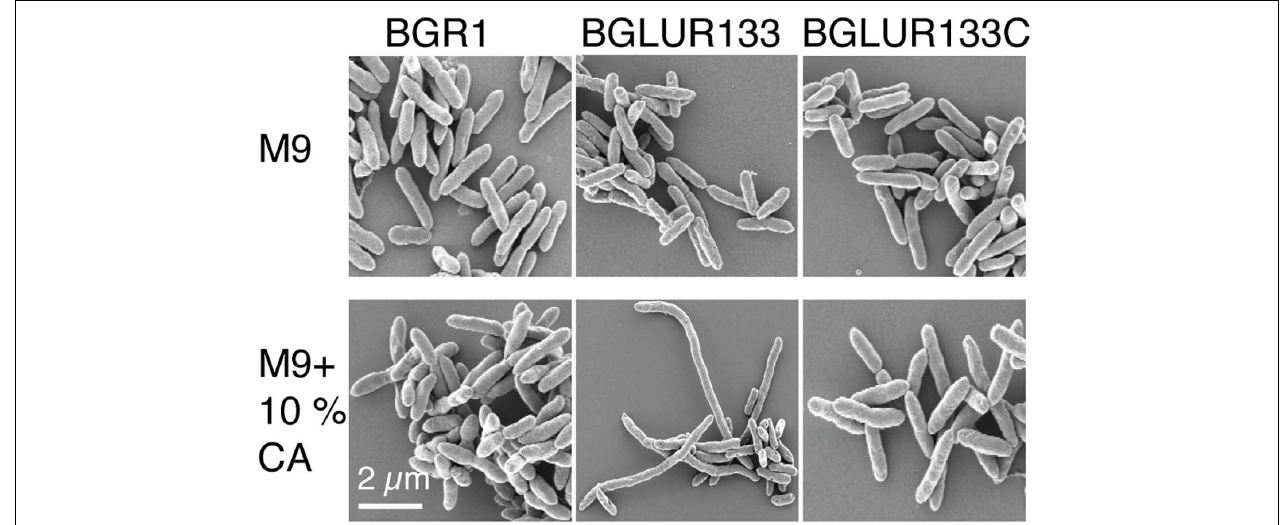
FIGURE 5 | Extracellular amino acids promote filamentation in response to GluR mutation. The indicated bacterial strains were cultured overnight in M9 minimal medium with or without 10% casamino acids (CA) and processed for SEM analysis, and their morphology was observed using a Carl Zeiss GmbH Auriga